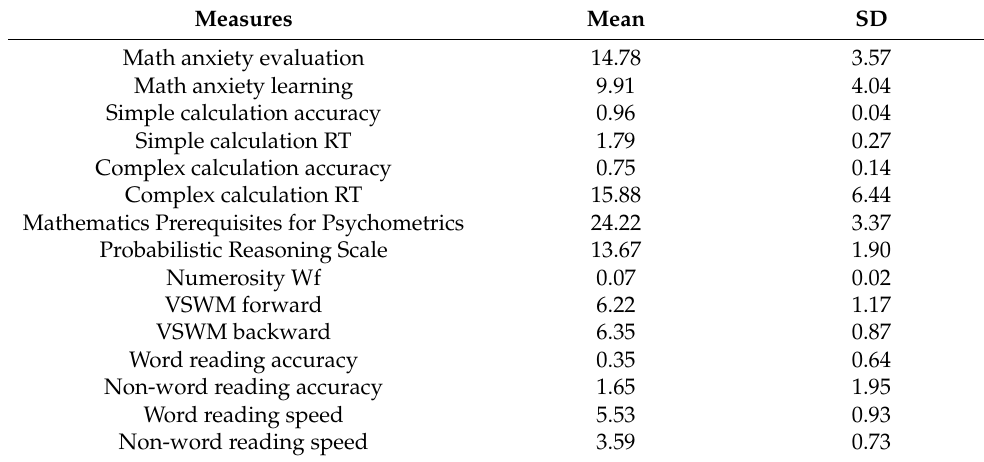
Table 1. Descriptive statistics. Mean and standard deviation (SD) of participants’ performance for the various measures.